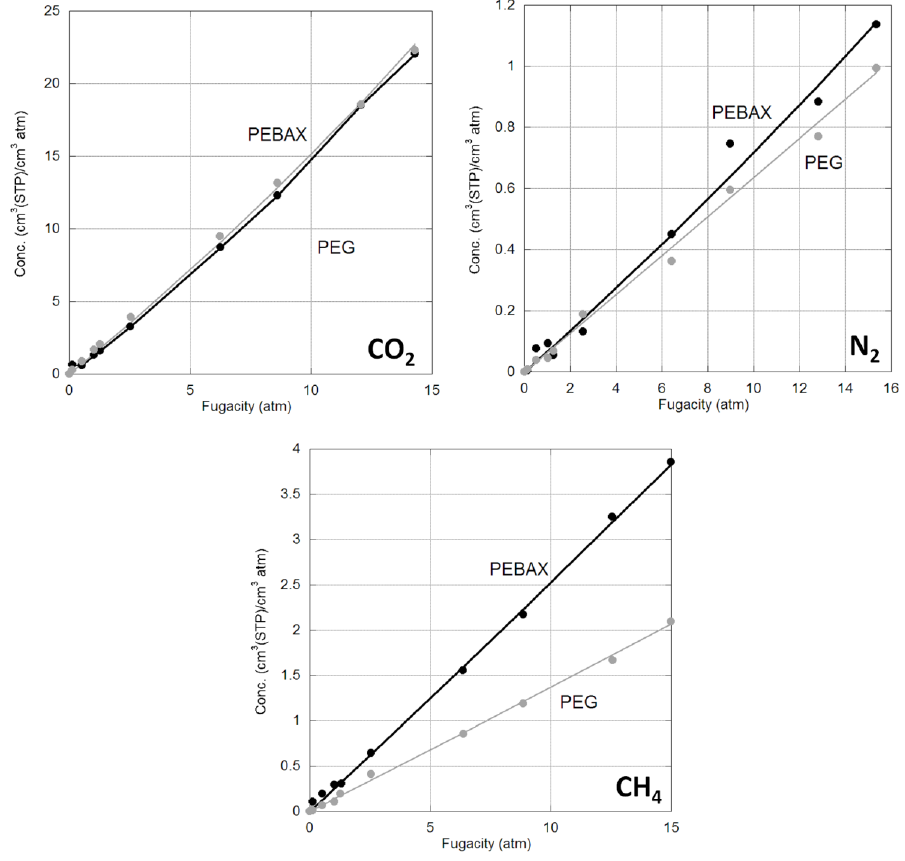
Figure 1. CO 2 , N 2 and CH 4 sorption isotherms in PEBAX (black) and PEG (grey) at 35 °C. Table 1. Henry’s law constants for pure gases in crosslinked PEG and PEBAX 2533 at 35 °C.